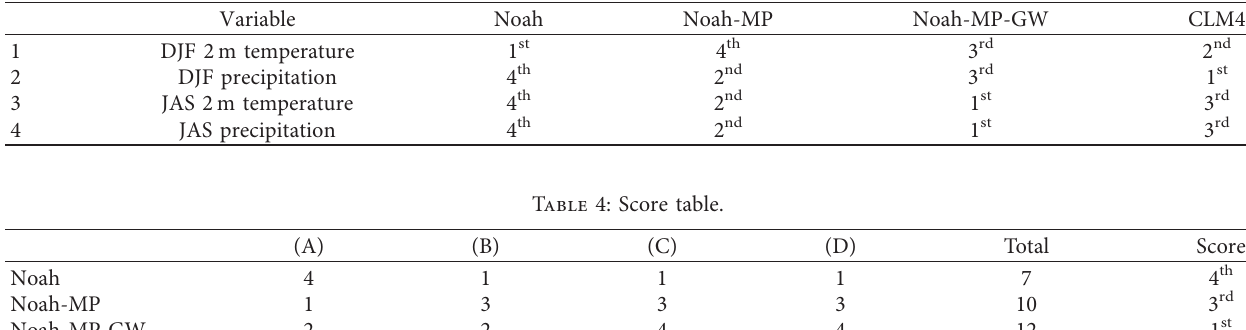
Table 3: Positions of each model in regards to their performance.